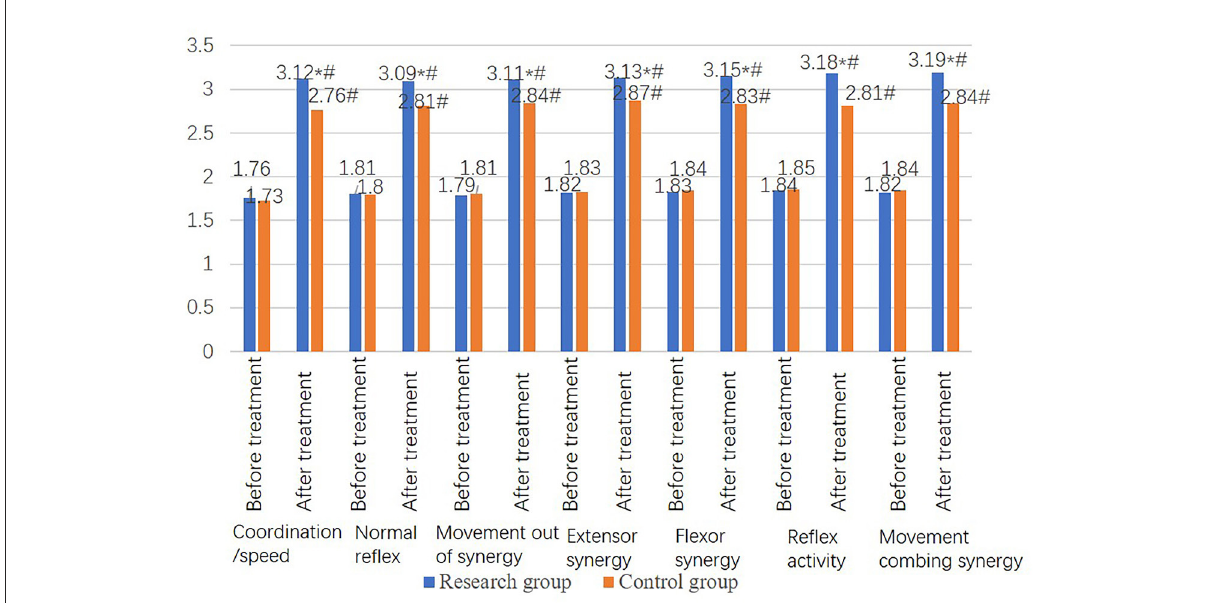
FIGURE3 Comparison of lower extremity motor function scores between the two groups. Lower extremity function in the research group including coordinate/speed, normal reflex, movement out of synergy, extensor synergy, flexor synergy, reflex activity, and movement combining synergy improved after treatment. Additionally, lower extremity motor function of the research group after treatment was significantly better than that of the control